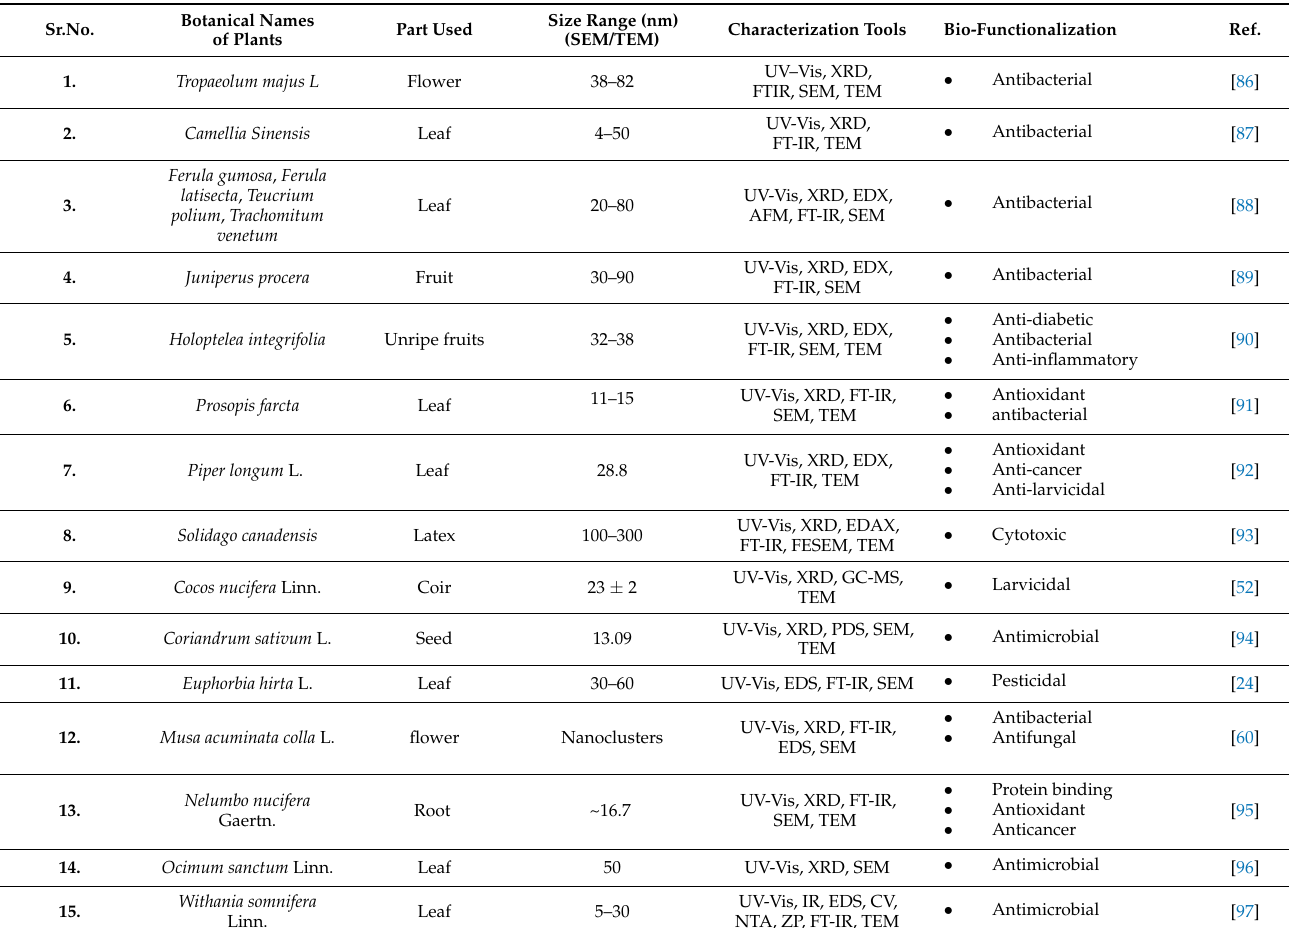
Table 3. Bio-reduction of silver NPs and their